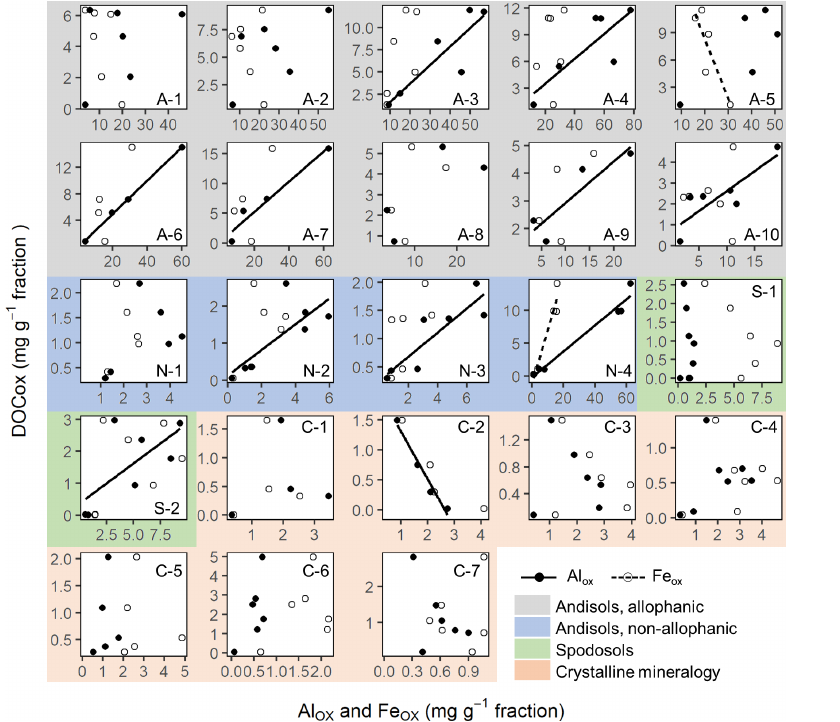
Figure A7. Scattered plots of acid-oxalate-extractable Fe and Al against dissolved organic C concentration for each soil sample. Soil sample ID in each plot corresponds to that from Table 1. Solid lines represent significant linear regressions at p < 0 . 1.